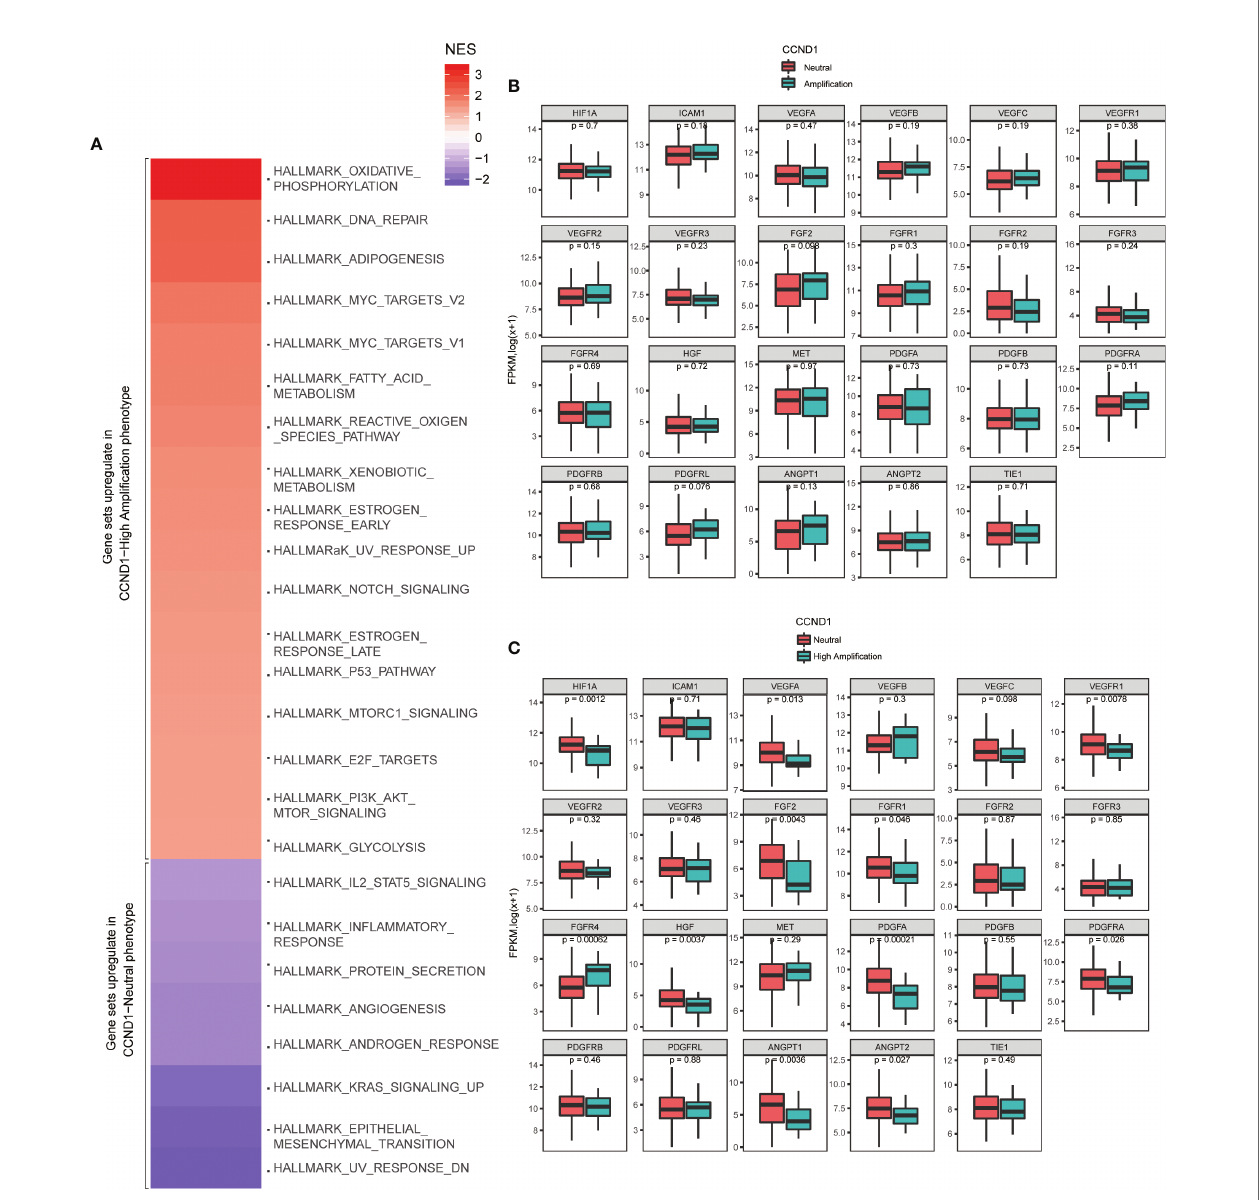
FIGURE 5 | Identi fi cation of signaling pathways and angiogenesis molecules associated with CCND1 ampli fi cation in patients with melanoma included in the TCGA database ( n =237). (A) Activated signaling pathways in patients with melanoma from the TCGA database categorized into CCND1 High Ampli fi cation and Neutral groups using GSEA analysis. Prevalence of TME-related angiogenesis molecules in patients with melanoma from the TCGA database categorized into (B) CCND1 Ampli fi cation and Neutral groups and (C) High Ampli fi cation and Neutral groups. TCGA, The Cancer Genome Atlas; TME, tumor